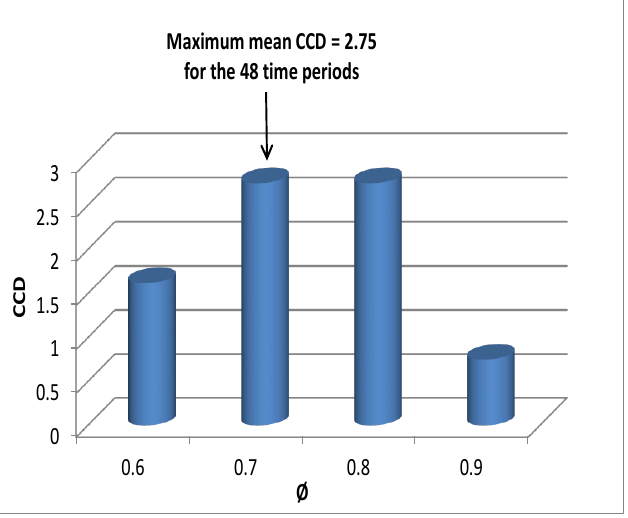
Figure 21. The mean values of connected clusters’ dissimilarity versus the weight coefficient φ in the case of time period = 20